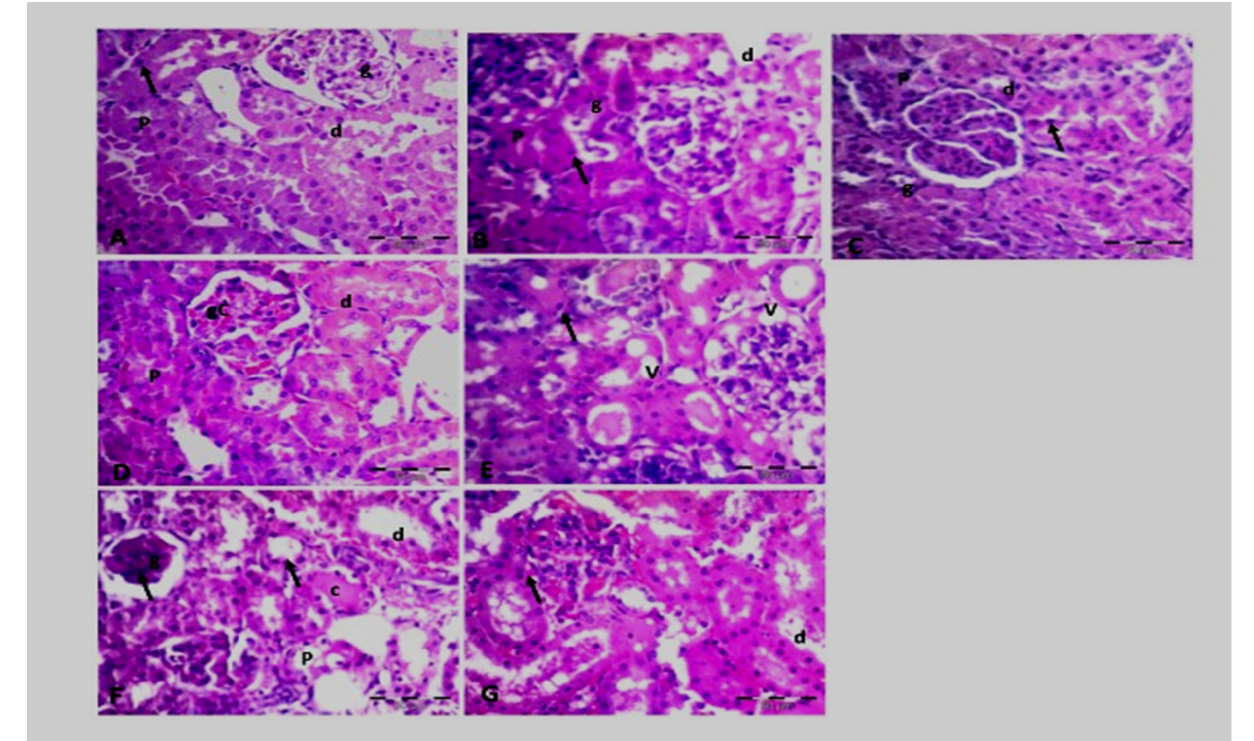
Figure 12. Photomicrographs of renal cortex of ( A – C ): groups 4, 6, and 8, respectively, showing renal tissue nearly approach normal; renal glomerulus ( g ), proximal convoluted tubules (PCT), and distal convoluted tubules ( d ) except for a few dark dense nucleoli (arrows) could be detected in previously structures. ( D ) and ( E ) (10 and 7, respectively) showing globular congestion ( gc ) and both tubular and globular vacuolation (V). Notice the more notable apoptotic cells (arrows) than the previously mentioned drugs. ( F ) and ( G ) groups (5 and 9, respectively) showing shrunken glomerulus (g), intratubular hyalin cast (c), dilated tubules ( p , d ) and more observable apoptotic cells (arrows). H & E, × 400.